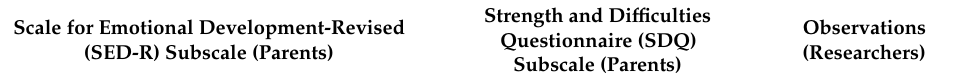
Table 2. Shared underlying constructs measured by the two questionnaires administered to the parents and systematic observations by the